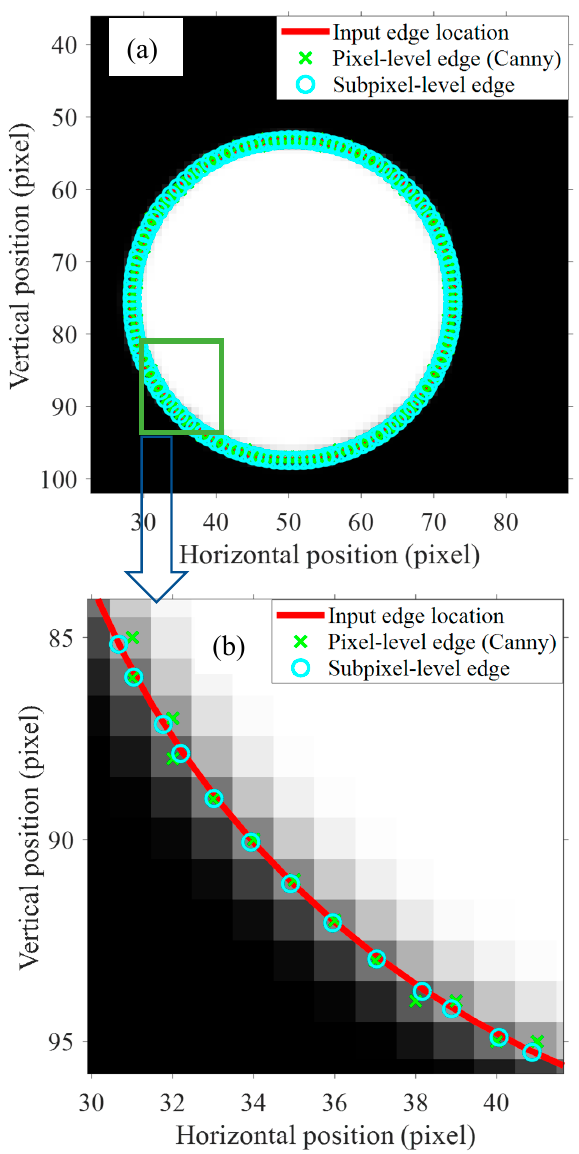
Figure 4. Performance of subpixel method and integer-pixel method. ( a ) The overall image, ( b ) Zoom-in detail of ( a